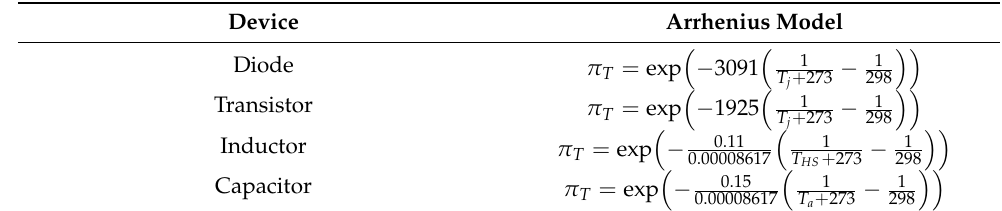
Table 2. Arrhenius model for each